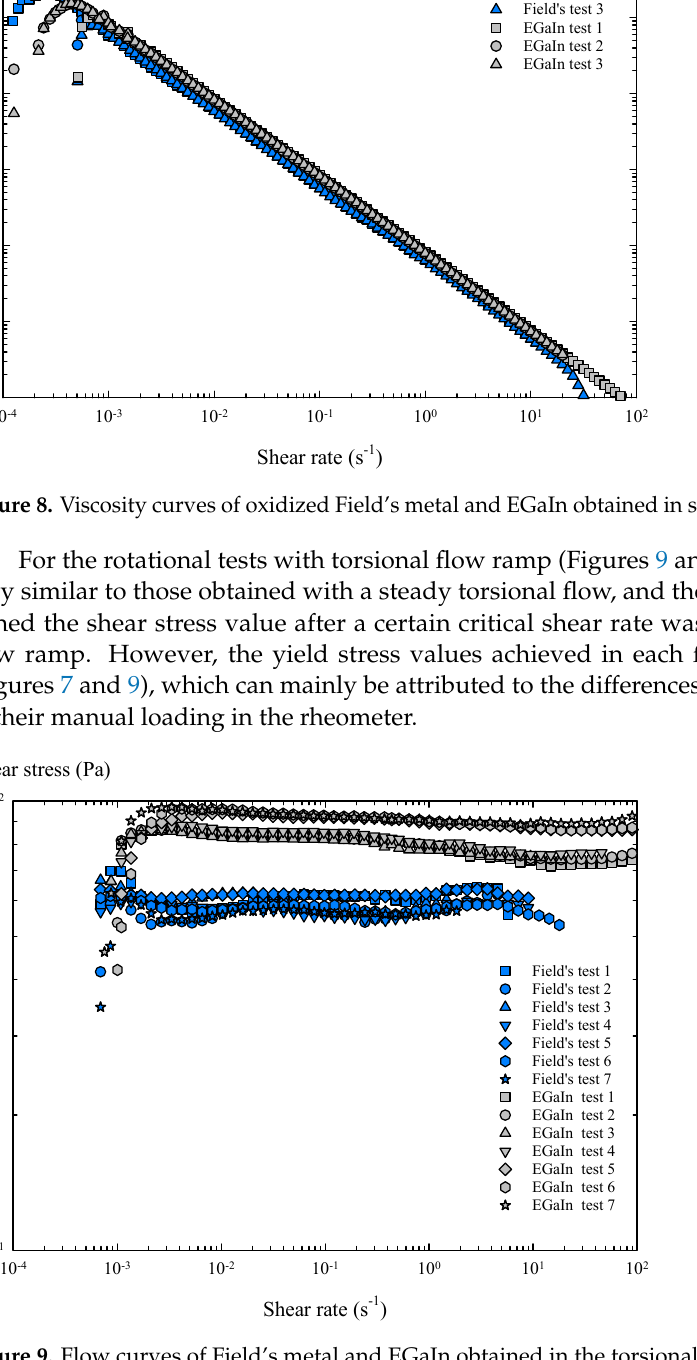
Figure 9. Flow curves of Field’s metal and EGaIn obtained in the torsional flow ramp tests. The shear viscosities of these oxidized metals follow the same behaviour as the steady torsional flow tests (Figures 8 and